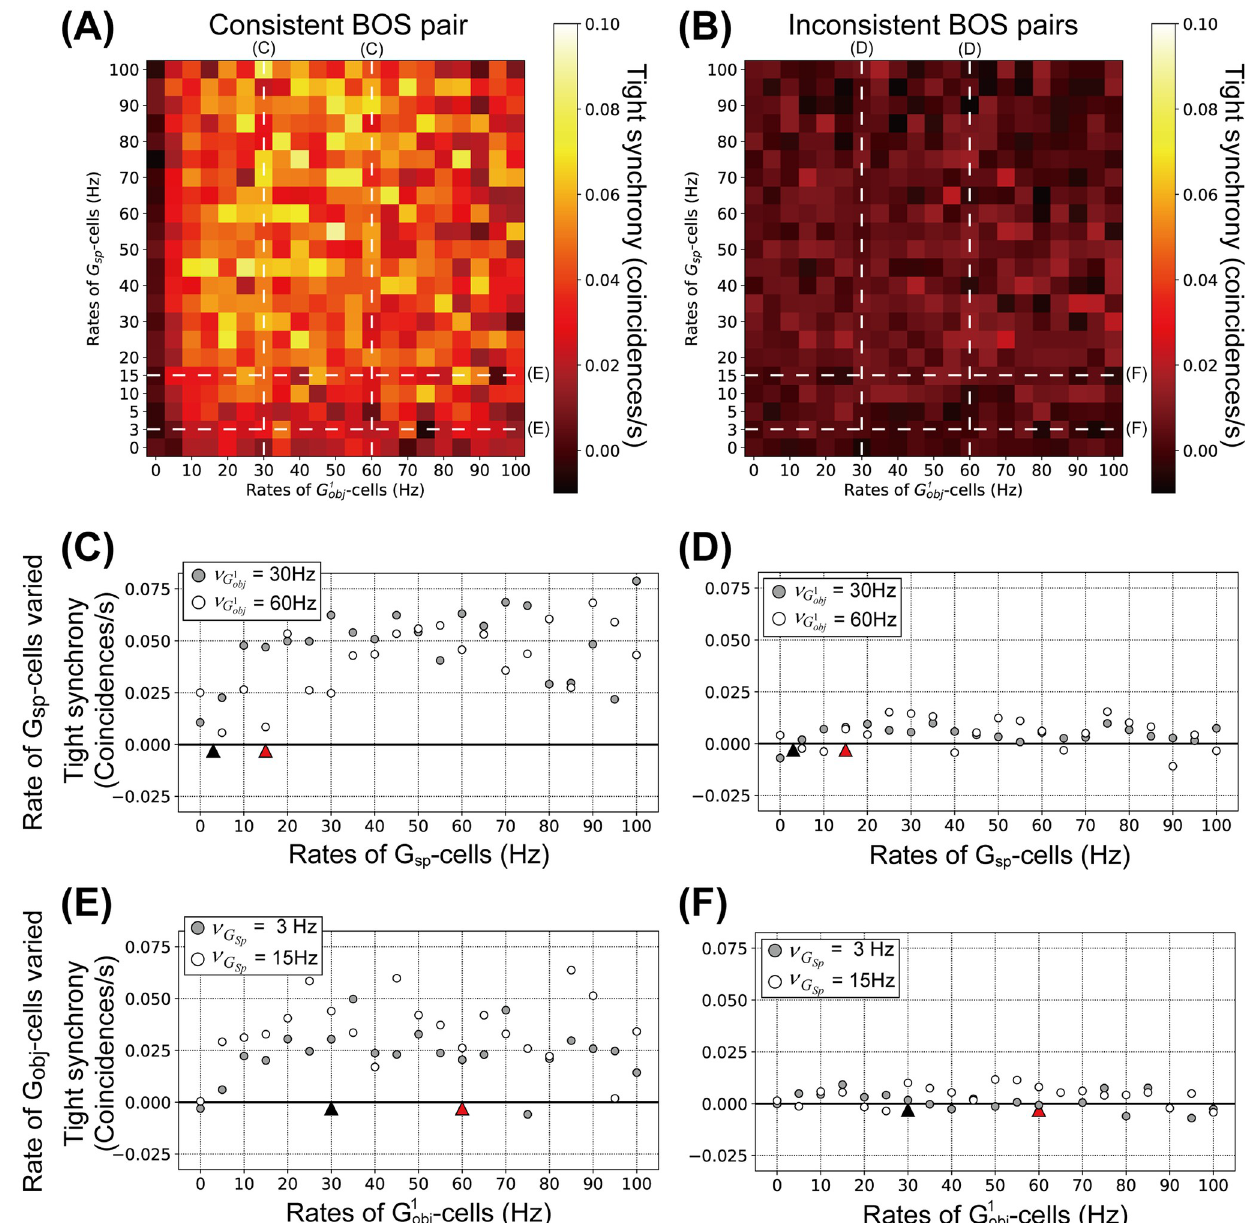
Fig 8. Tight synchrony for model BOS neurons as function of the mean rates of G -cells. Shown is the integral of the tight correlation in the range of ± 5 and BOS 2 neurons (consistent pair) with respect to combinations of G 1 - and G sp -cells rates. ms interval around lag zero. A: Tight synchrony between BOS 1 R L obj B: Tight synchrony between all inconsistent pairs. Modulation patterns of tight synchrony labelled by white dashed lines with ‘C’, ‘D’, ‘E’ and ‘F’ are summarized in panels C, D, E and F as functions of the mean rates of G -cells, respectively. C: Tight synchrony for consistent pair as a function of the mean rates of G sp for mean rates of G 1 of 30Hz (filled circles) and 60Hz (open circles). Black and red triangles are the same as those in Fig 6C. D: Tight obj synchrony between BOS neurons for inconsistent pairs as a function of the G sp rate. Conventions as in panel C. E: Tight synchrony between consistent pair as a function of the mean rates of G 1 for mean rates of G -cell of 3Hz (filled circles) and 15Hz (open circles). Black and red triangles are the same as those sp obj rate. Conventions as in panel F. in Fig 6E. F: Tight synchrony between BOS neurons for inconsistent pairs as a function of G 1 obj